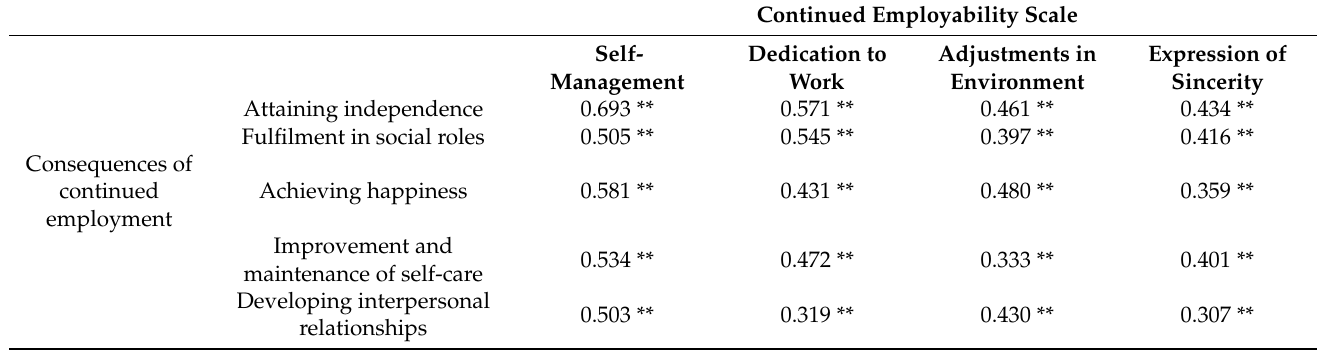
Table 7. Correlations between Continued Employability Scale subscales and consequences of contin- ued employment